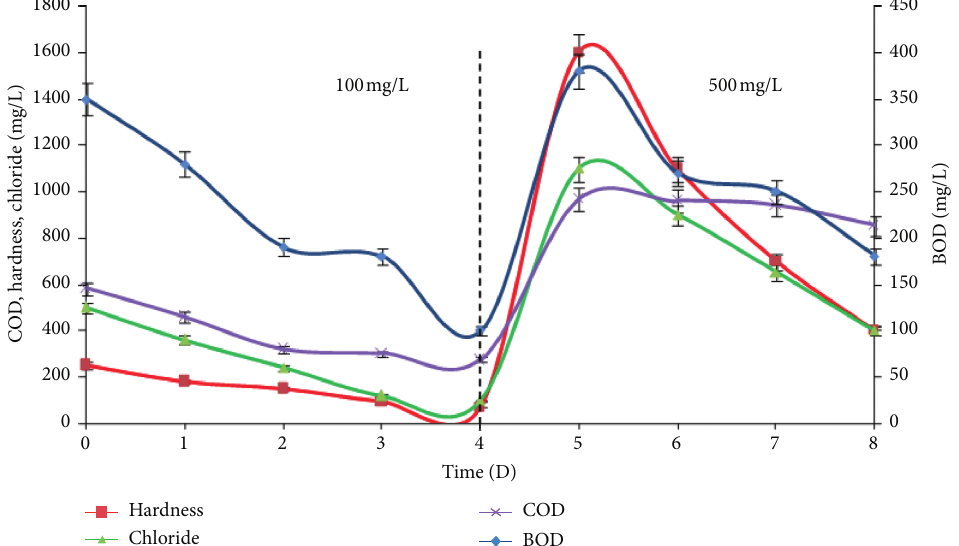
Figure 8: Removal of BOD, COD, hardness, and chloride in the sequential anaerobic-aerobic treatment processes carried out in the An-SBR and aerobic MBBR.